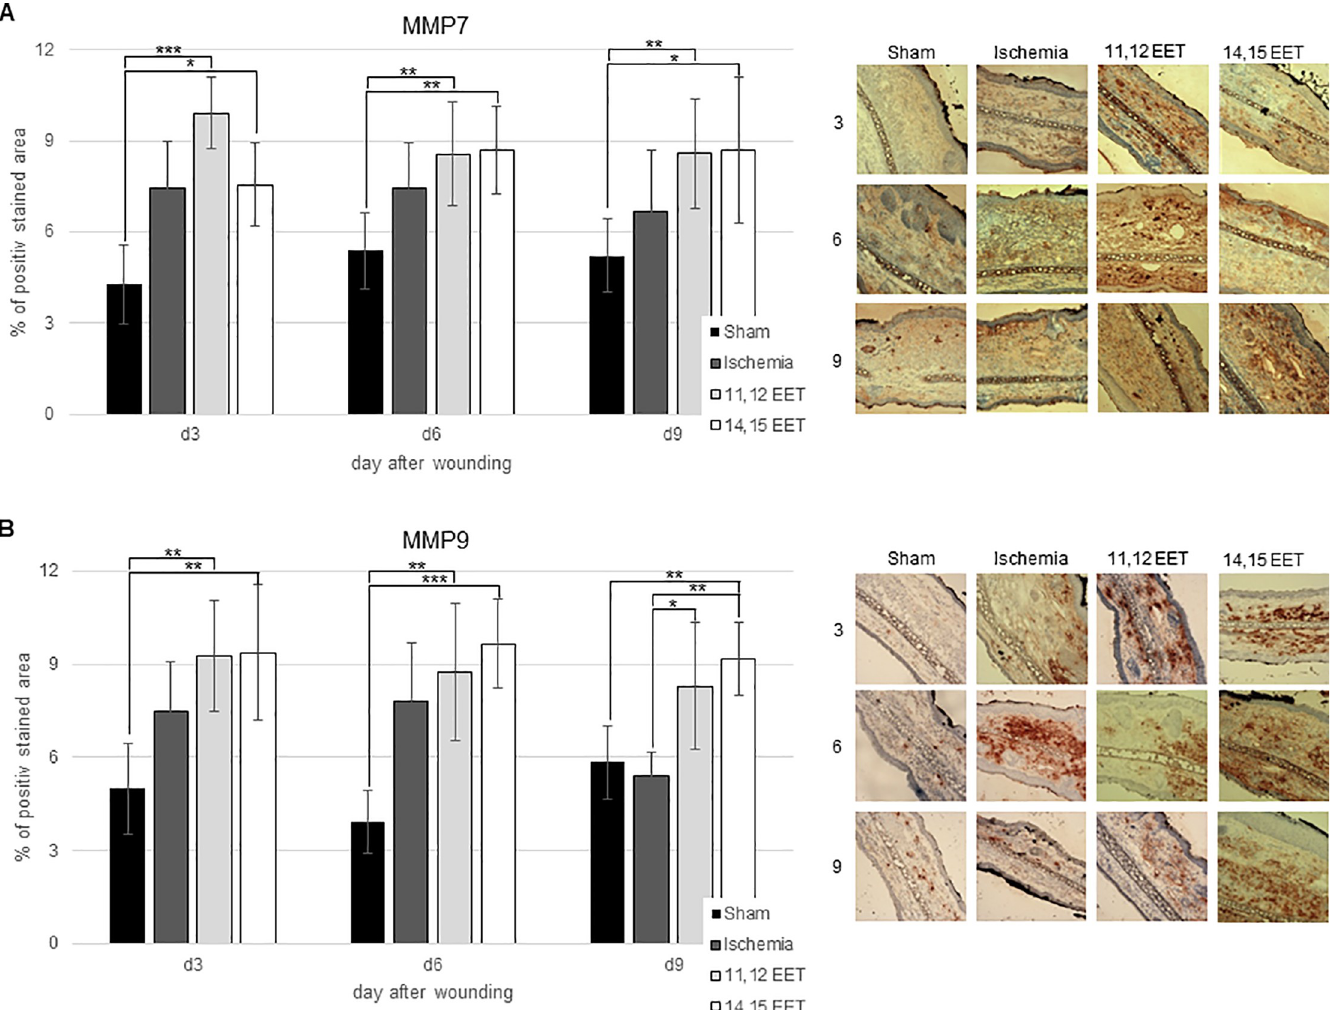
Fig 5. A: Percentage of MMP7 positive area on day 3, 6 and 9 after wounding of control, ischemic and 11,12 as well as 14,15 EET treated ischemic wounds. On the right representative pictures of immunohistological staining. B: Percentage of MMP9 positive area on day 3, 6 and 9 after wounding of control, ischemic and 11,12 as well as 14,15 EET treated ischemic wounds. On the right representative pictures of immunohistological staining (data is shown as mean ± SD; n = 8 ). � p < 0.05, �� p < 0.01, ��� p < 0.001.